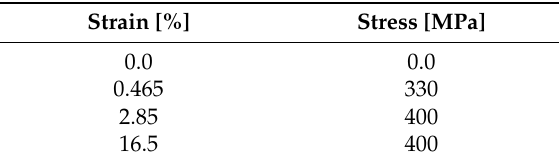
Table 4. Stress-strain data for AA2024-T3 layer used in the elastic-plastic FE simulations [20].